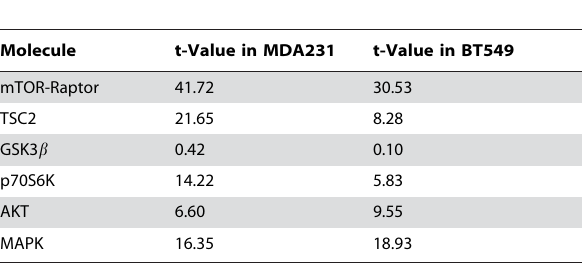
Table 2. The T-Values for the Molecules Sampled in the Microarray.